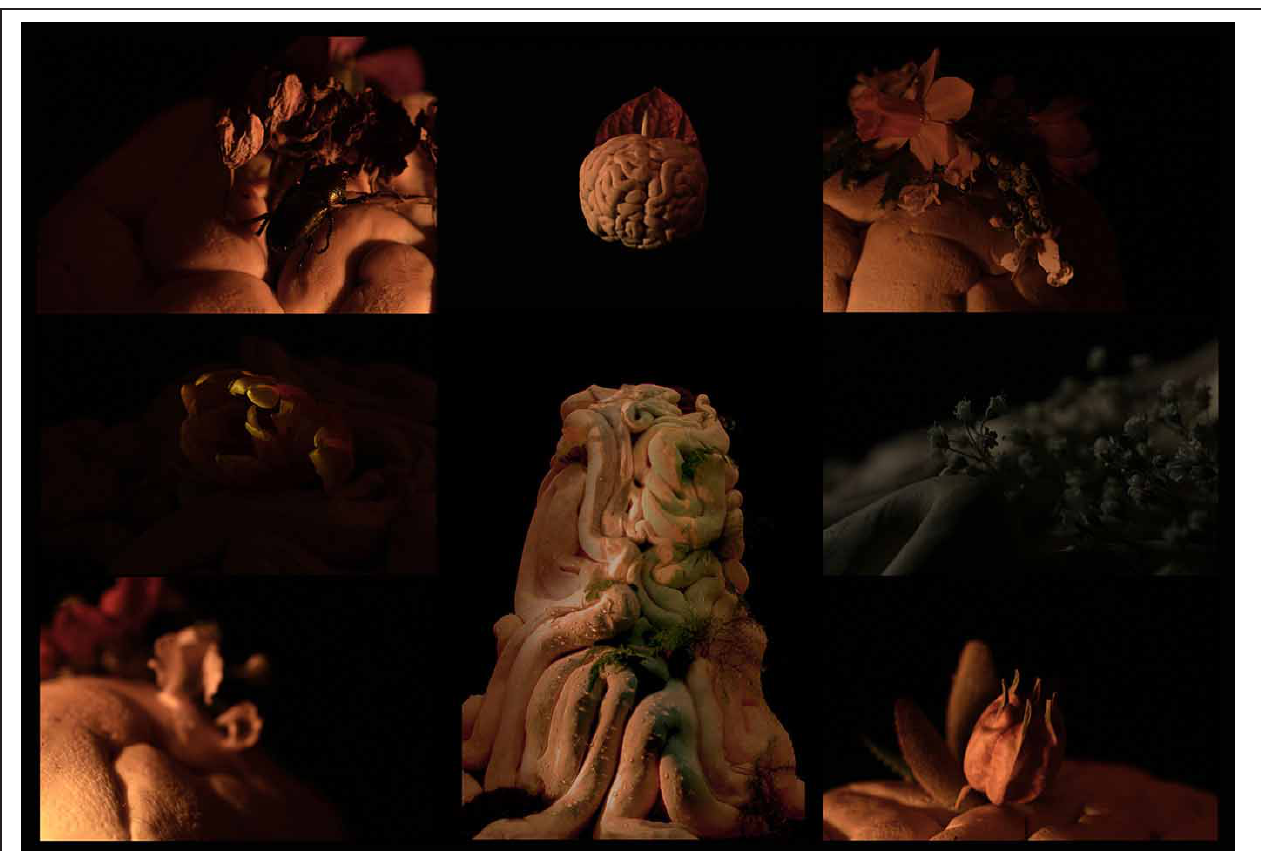
FIGURE 3 | The cortical garden (2009). Photo video installation: digital print on velvet paper and video (Dimension variable).